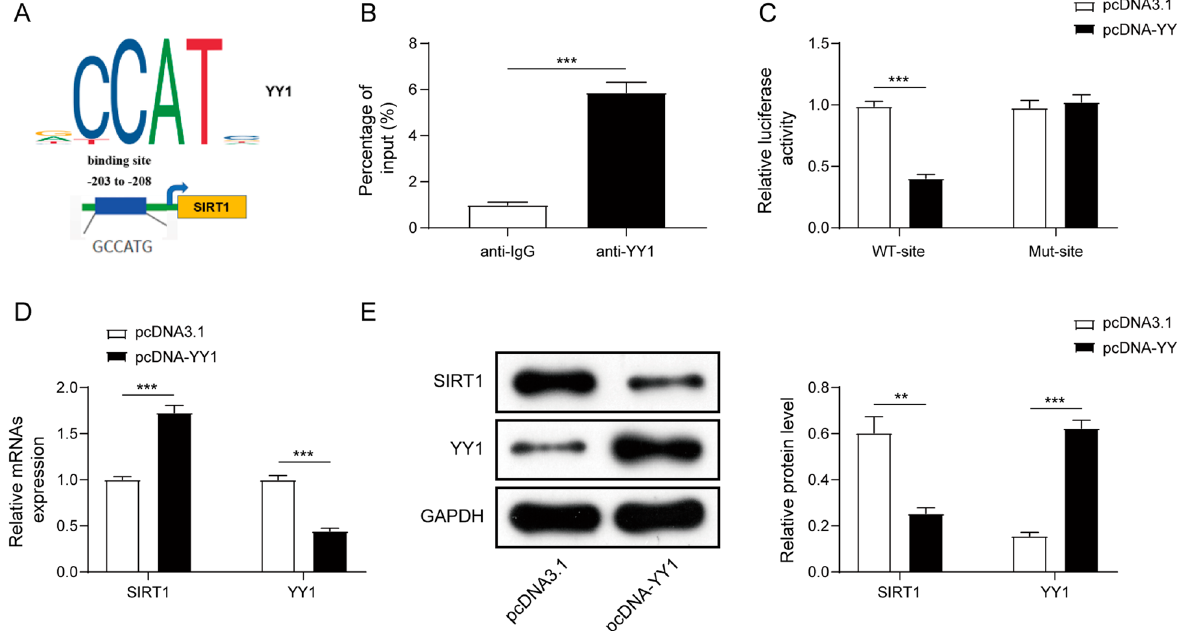
Fig. 4 YY1 downregulated the expression of SIRT1 by inhibiting its transcription. Synoviocytes were transfected with pcDNA-3.1 or pcDNA-SIRT1. A JASPAR software predicted the potential binding site between YY1 and SIRT1. B ChIP detected the interaction between YY1 and SIRT1. C Dual-luciferase reporter assay detected the combination of YY1 and SIRT1. D The mRNA expression of SIRT1 was examined by qPCR. E The protein level of SIRT1 was examined by western blot. Experiments were carried out in triplicate, mean